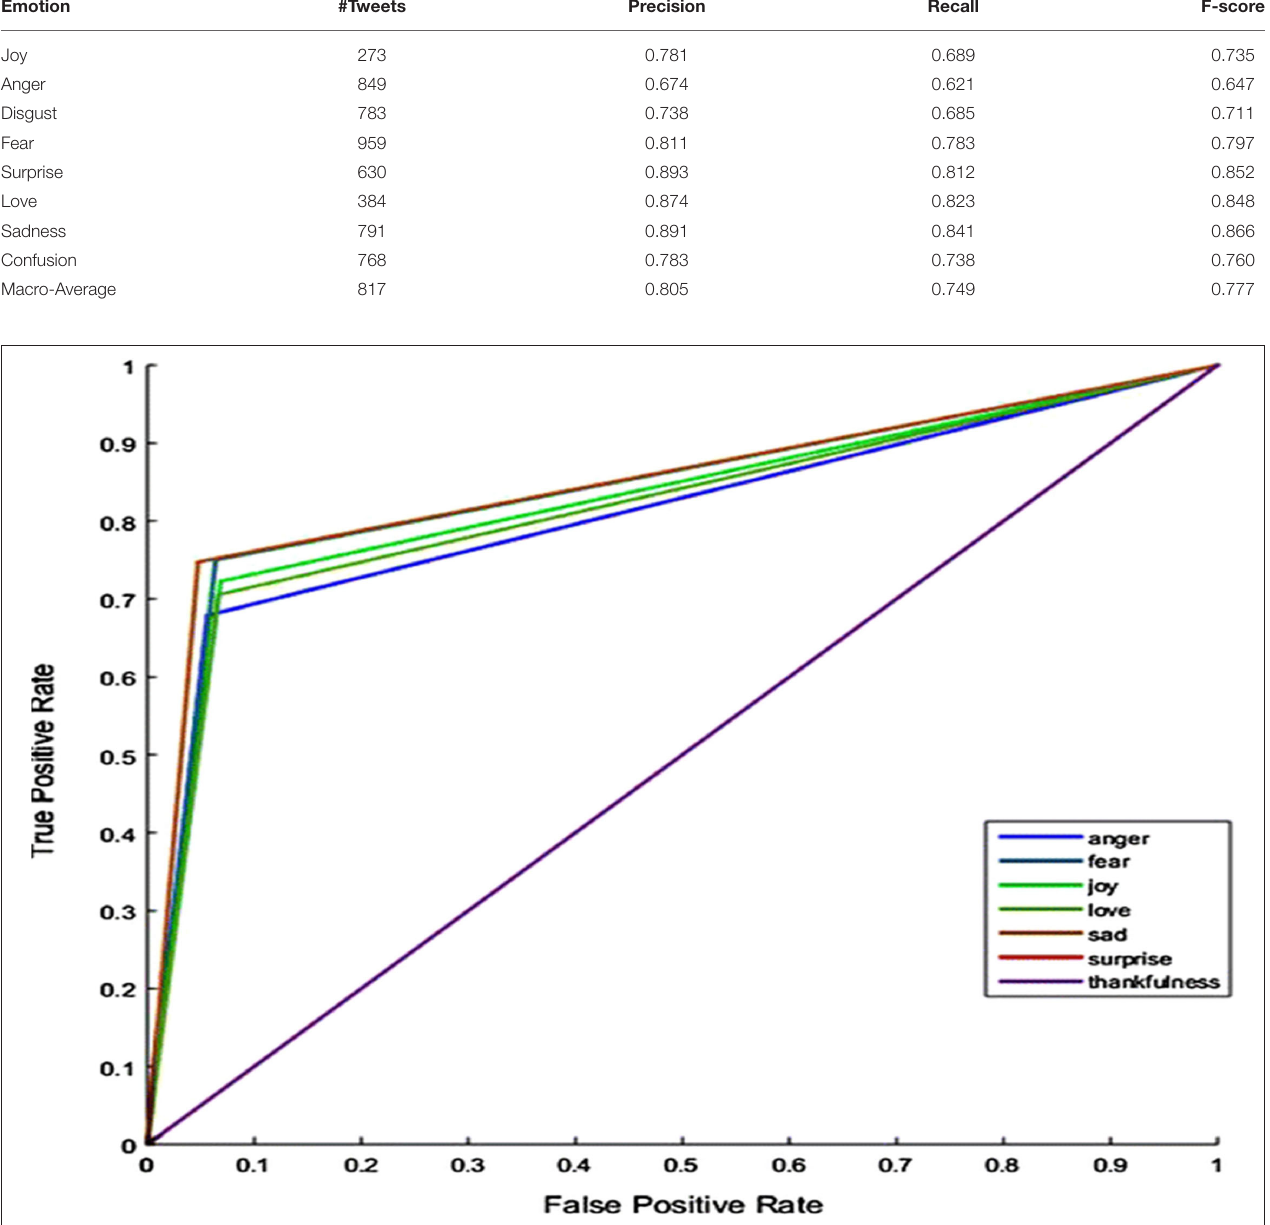
TABLE 6 | Emotion classifier for each emotion extracted from COVID-19 datasets. Emotion